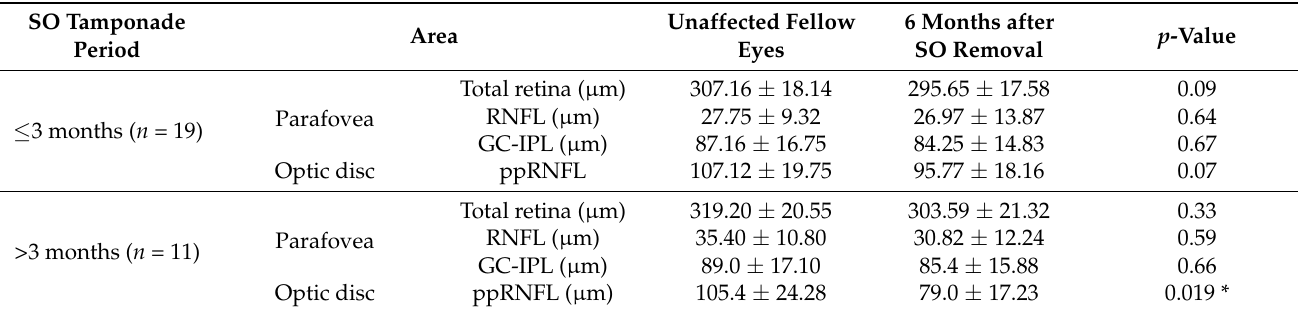
* Statistically significant difference ( p < 0.05) by paired t -test between unaffected fellow eye and 6 months after SO removal. SO, silicone oil; RD, retinal detachment; RNFL, retinal nerve fiber layer; GC-IPL, ganglion cell-inner plexiform layer; ppRNFL, peripapillary retinal nerve fiber